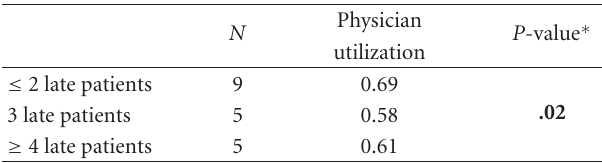
Table 5: Physician utilization stratified by number of late patients per clinic.